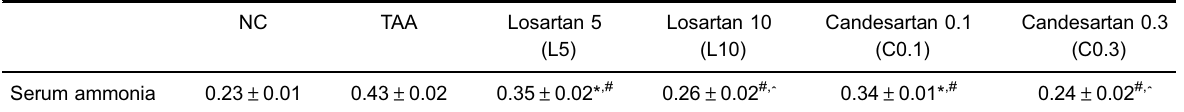
Table 1. Effects of losartan and candesartan for 14 days by gastric gavage on the serum level of ammonia ( m mol/mL) in thioacetamide (TAA)-induced chronic liver failure rats.